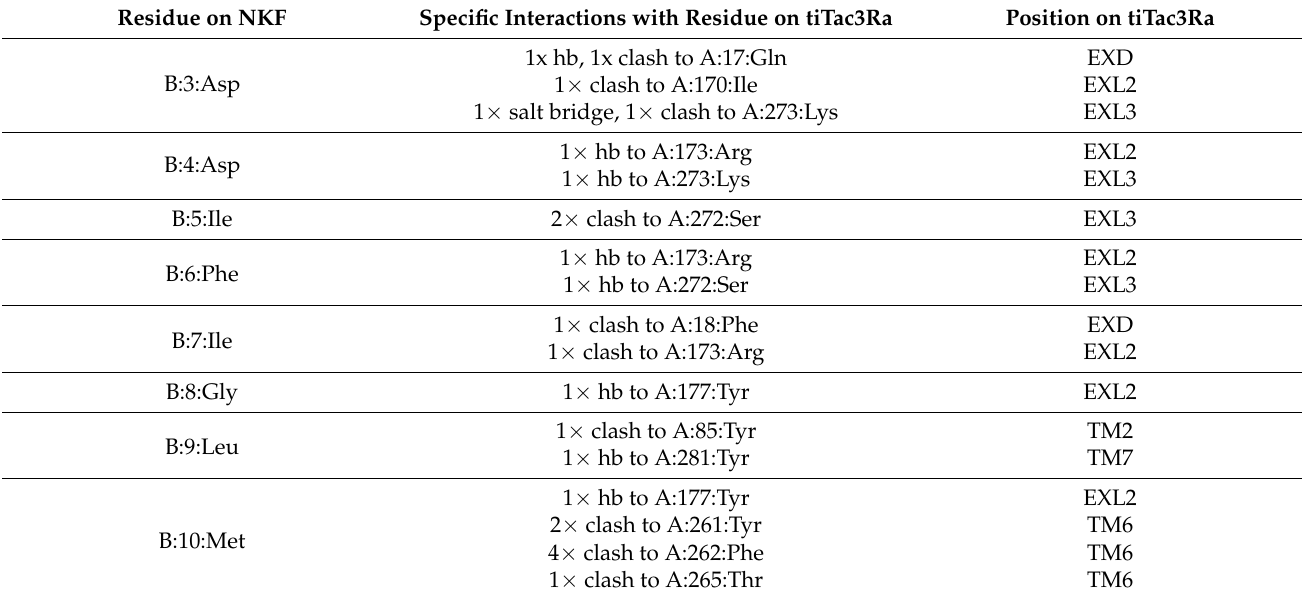
Table 4. IFD: Major Specific Binding interactions between tiTac3Ra and tiNKB. (Refer Figure 4). Residue on NKF Specific Interactions with Residue on